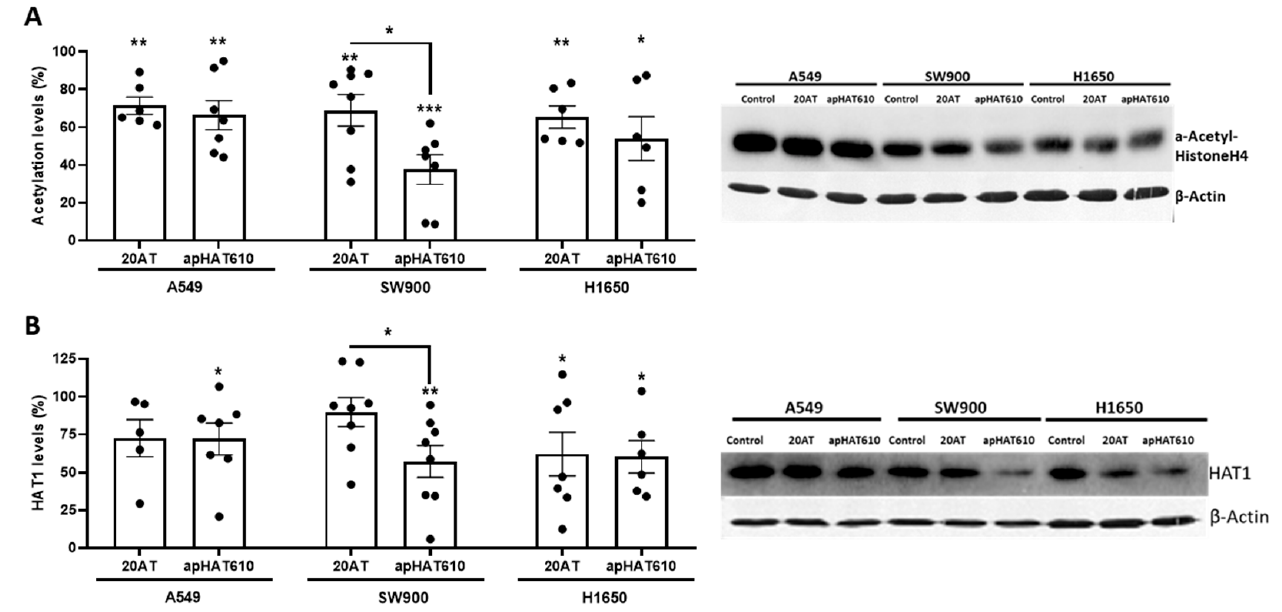
Figure 8. Effect of apHAT610 on histone H4 acetylation levels at 24 h post-transfection. A549, SW900, and H1650 cells were seeded on p6 at density 5 × 10 5 cells/well and transfected at 24 h with the previously established working concentrations. After the assay time elapsed, the cells were collected and lysed. Subsequently, immunodetection with a specific antibody was performed by 15% SDS-PAGE. ( A ) Histone H4 acetylation levels and ( B ) HAT1 levels at 24 h post-transfection. Data are expressed as the percentage relative to the value in control cells and represent the mean ± SEM of at least eight independent experiments (* p < 0.05; ** p < 0.01; *** p < 0.001). The images on the right correspond to representative experiments from the assays performed with the acetylated histone H4-specific or HAT1-specific antibodies. β -Actin was the loading control.